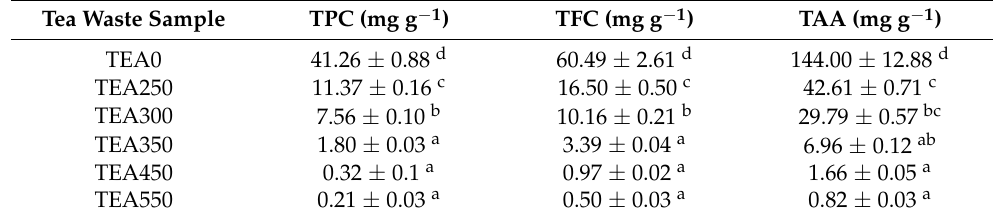
Table 4. Total phenolics (TPC), flavonoids (TFC), and total antioxidant activity (TAA) of the methanol extract from black tea. Values are means ± SE ( n = 3). Different letters (a–d) indicate significant differences based on Tukey’s test ( p <